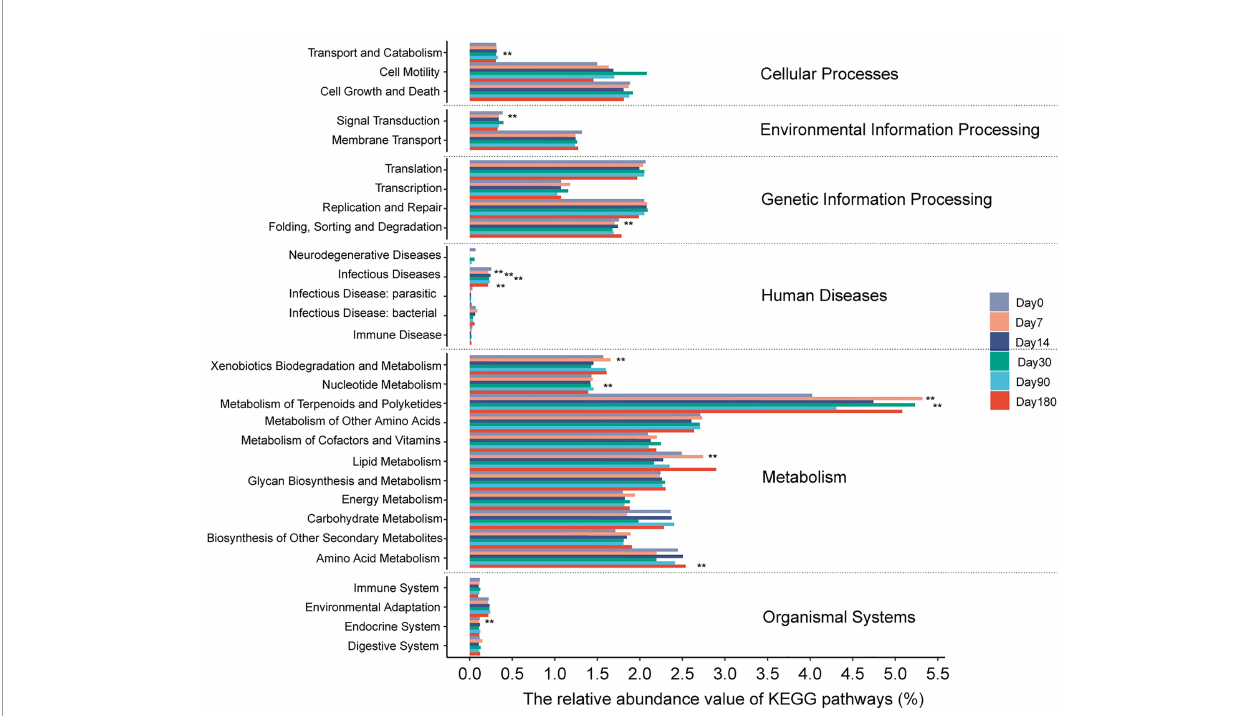
FIGURE 7 | The relative abundance of each predicted functional category given in the KEGG pathways (level 2). The functional pathway between each time point and before treatment. Signi fi cance was measured using the Wilcoxon rank-sum test ( P < 0.05, **). Day 0: before treatment; day 7: 7 days after treatment; day 14: 14 days after treatment; day 30: 30 days after treatment; day 90: 90 days after treatment; day 180: 180 days after